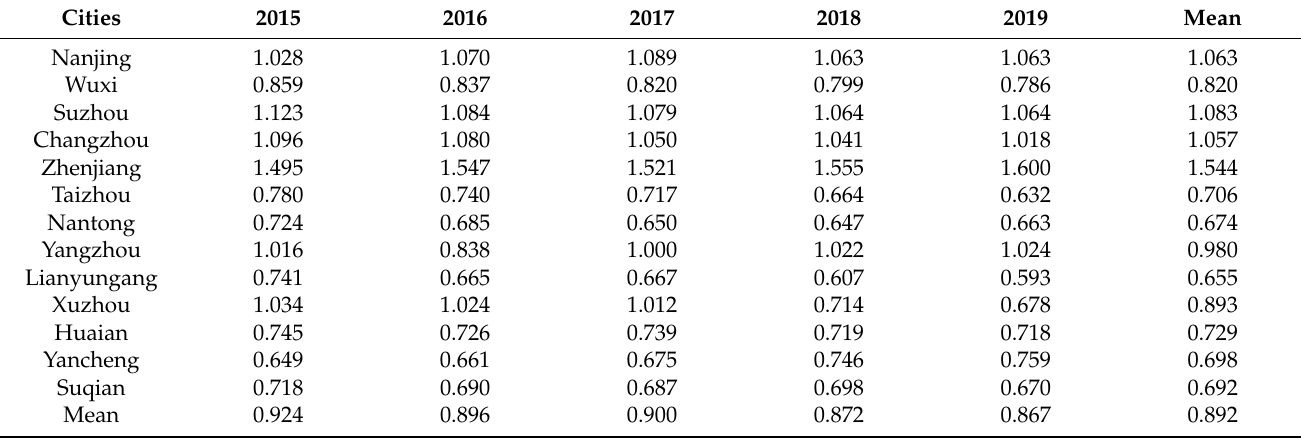
Table 4. Medical and health services efficiency value of Jiangsu Province from 2015 to